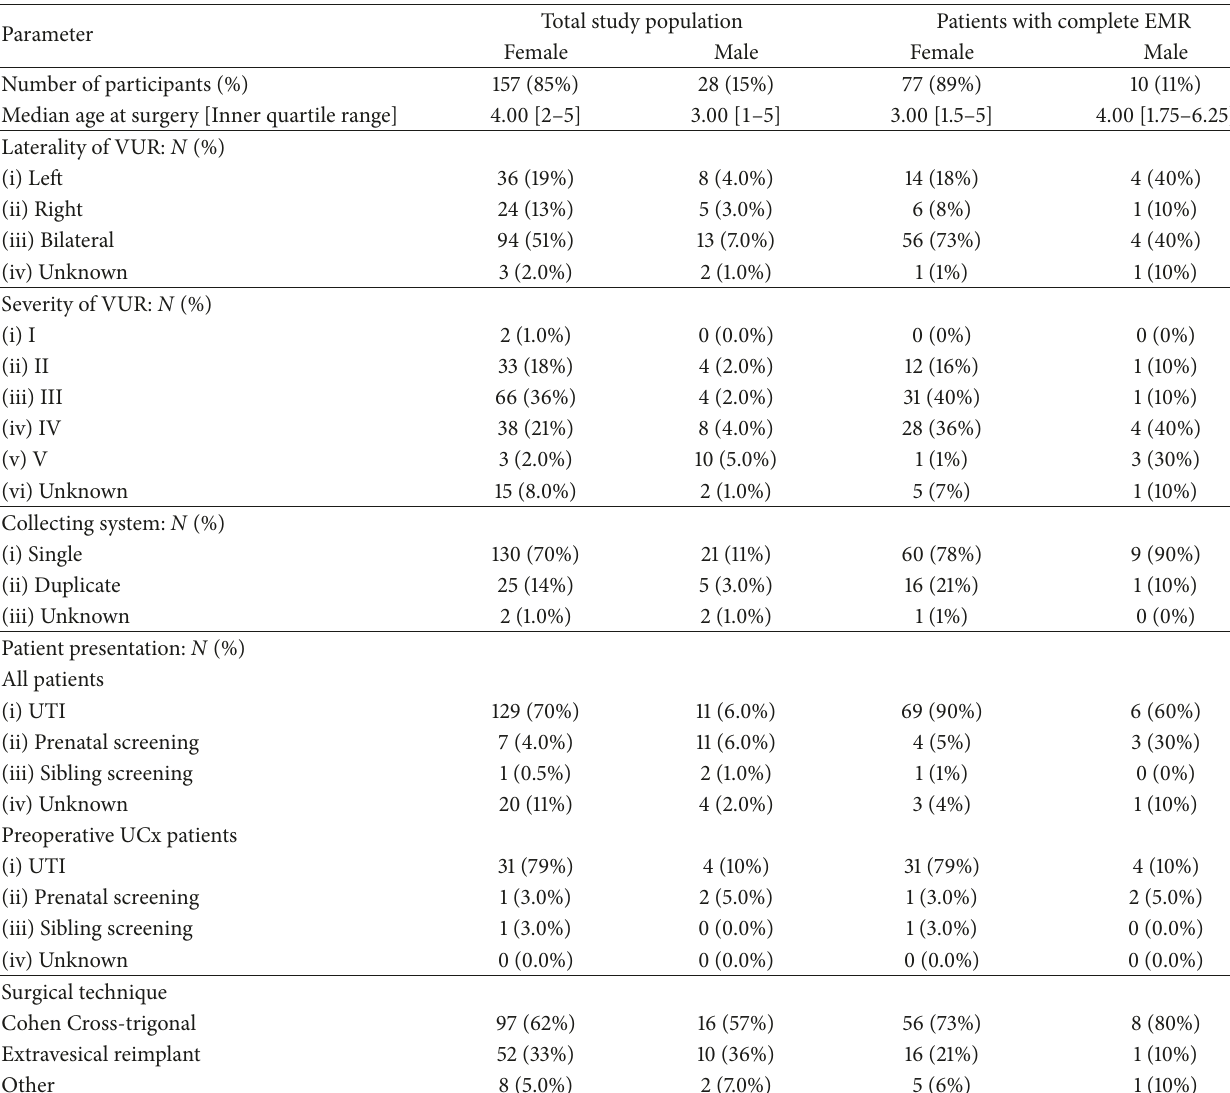
Table 1: Patient demographics of all 185 patients found to have ureteral reimplantation between 2000 and 2014 and the corresponding 87 patients with complete electronic medical